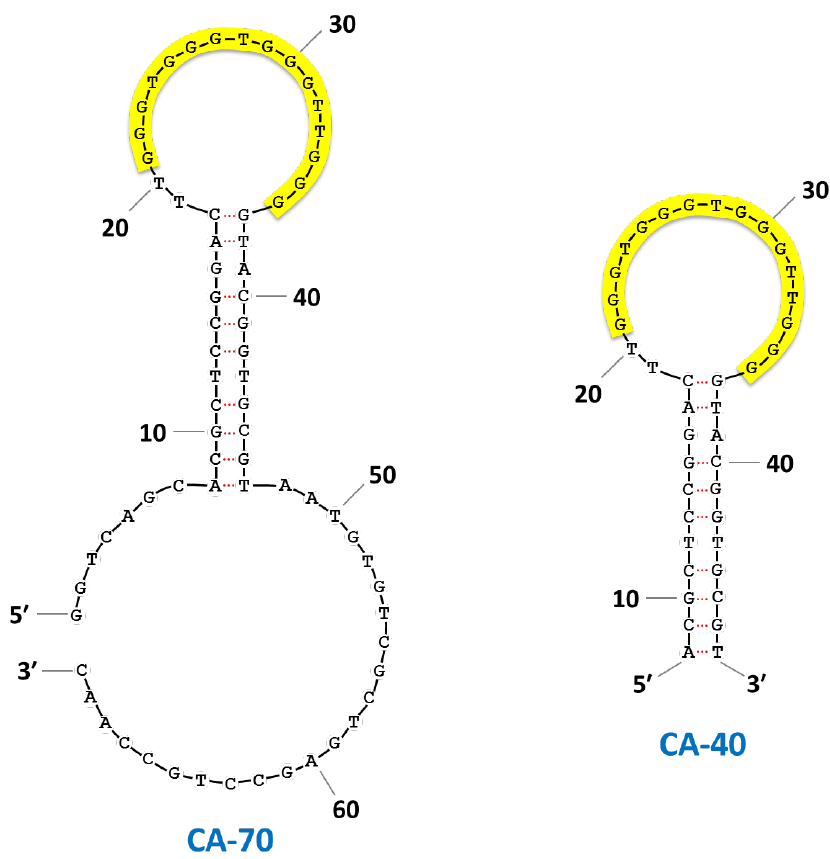
Figure 6. Predicted secondary structures of CA-70 and -40 using mfold-DNA folding form. The G-quadruplex motif was highlighted with